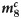
Fits of best PROSA (m1), SERIA (m8c) and SERIAlr (m13c) models.Columns display the normalized histogram of the RTs of pro- (red) and antisaccades (blue) in each of the conditions. Rows correspond to individual subjects named S1 to S4 for display purpose. As in Fig 6, prosaccade trials are displayed on the upper half plane, whereas antisaccade trials are displayed in the lower half plane. The predicted RT distributions based on the samples from the posterior distribution are displayed in solid (SERIAlr), broken (SERIA), and dash-dotted (PROSA) lines. Note that data from subject 3 in the PP50 condition is the same as shown in Fig 6. Early outliers are not displayed.